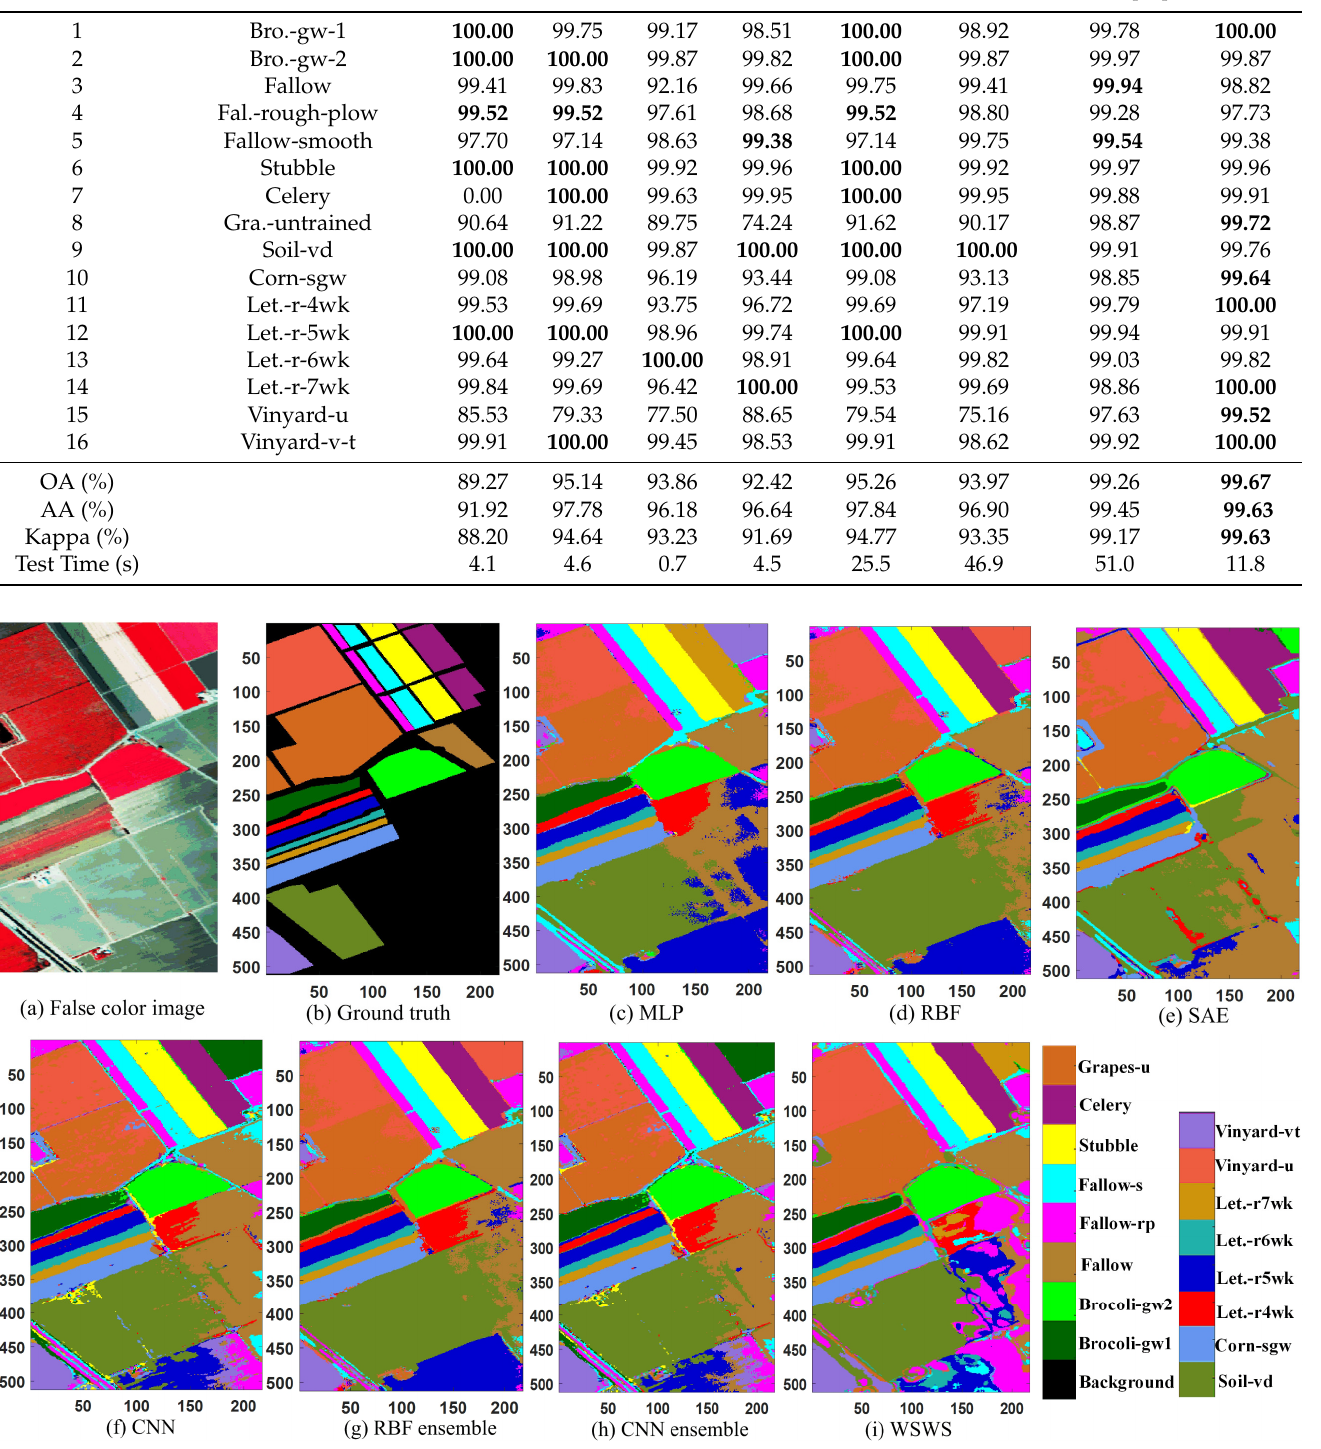
Figure 6. Classification results of Salinas data. ( a ) Original image, ( b ) ground truth (there are no class labels for the black background), ( c ) MLP, ( d ) RBF, ( e ) SAE, ( f ) CNN, ( g ) RBE ensemble, ( h ) CNN ensemble, and ( i )